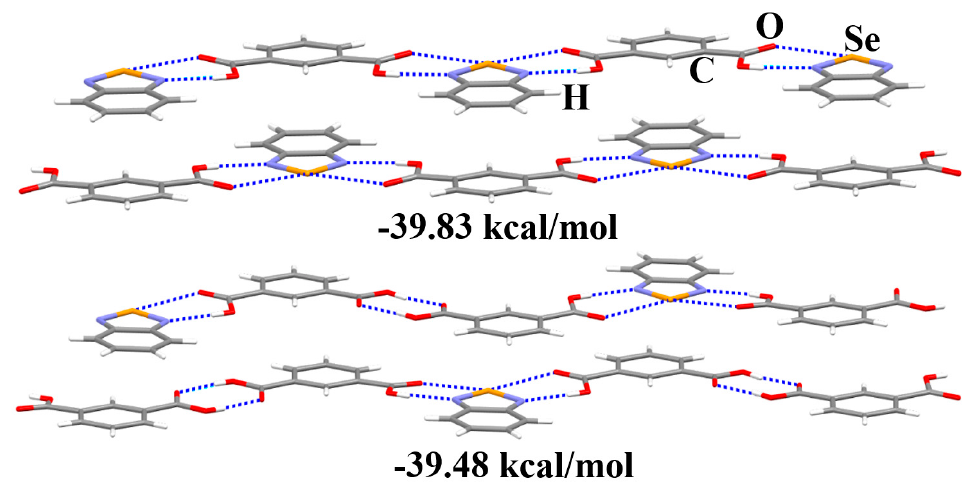
Figure 7. The π ··· π stacking interaction energies for the complexes in cocrystals 1 (top) and 2 (bot- tom).